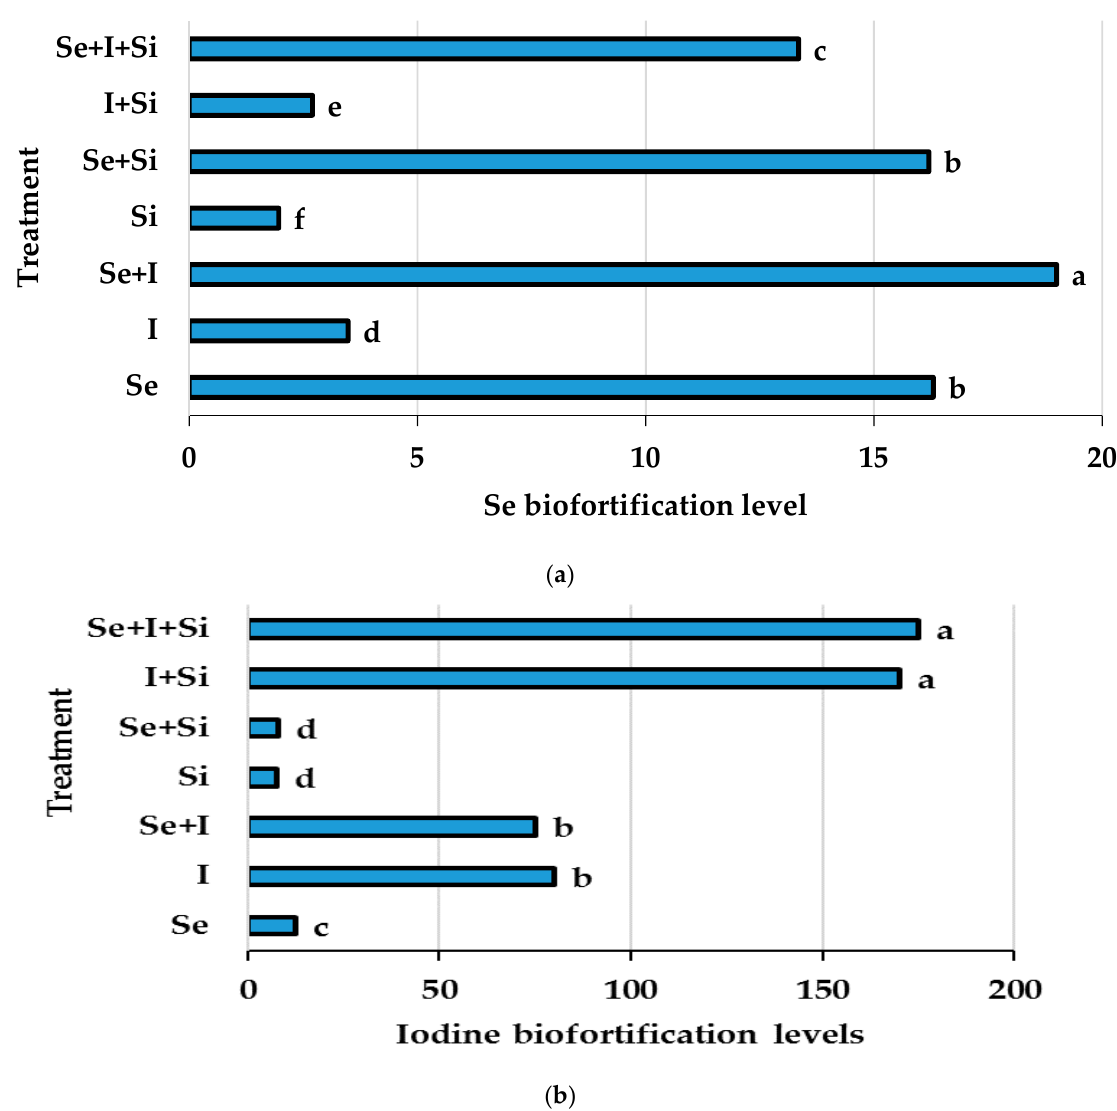
Figure 3. Biofortification levels (BL) of Se ( a ) and I ( b ) in chervil shoots under single and joint application of Se, I and Si (BF is equal to the ratio between element content in the treated and control plants). Values with the same letter do not differ statistically according to Duncan test at p < 0.05.